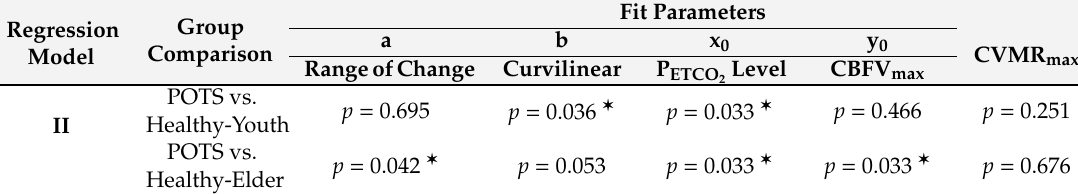
Table 6. Statistical results of average fit parameters between groups for fitting Models I and